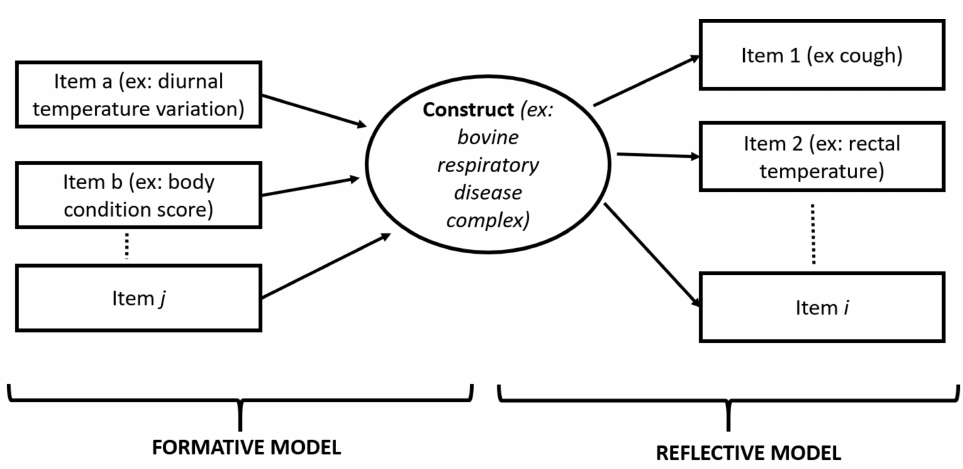
Figure 3. General framework to determine the specific items to be included for a specific construct or disease. Different items can be selected to assess a specific construct or determine a target condition. Reflective items are generally a reflection of the target condition or part of the description of the condition. In this example, cough or rectal temperature could be considered as part of the description of signs of respiratory disease (or the construct can cause them). By contrast, formative items can be considered as more causal items. They can cause the construct. In this example, diurnal variation of external temperature could be associated with an increased risk of bovine respiratory disease complex (BRD) but is not actually caused by BRD. For some items, it may be more difficult to determine both their formative and reflective roles. For example, the BCS could either be formative (e.g., calves with a low BCS could be at higher risk of being sick) or reflective (long disease duration may lead to a low